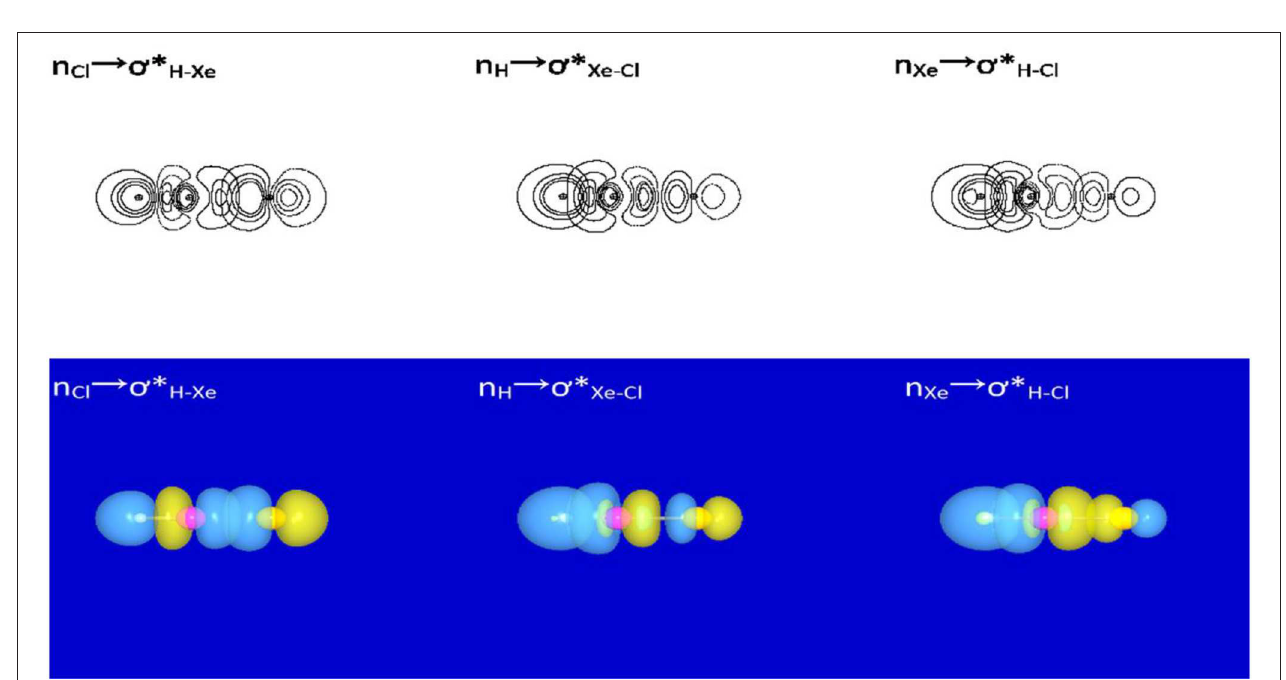
FIGURE 3 | NBO orbital contour diagrams and 3-D surface views of donor-acceptor interactions for HXeCl. shown in Figure 2 , where the H-Xe + :Y − (I) is the best